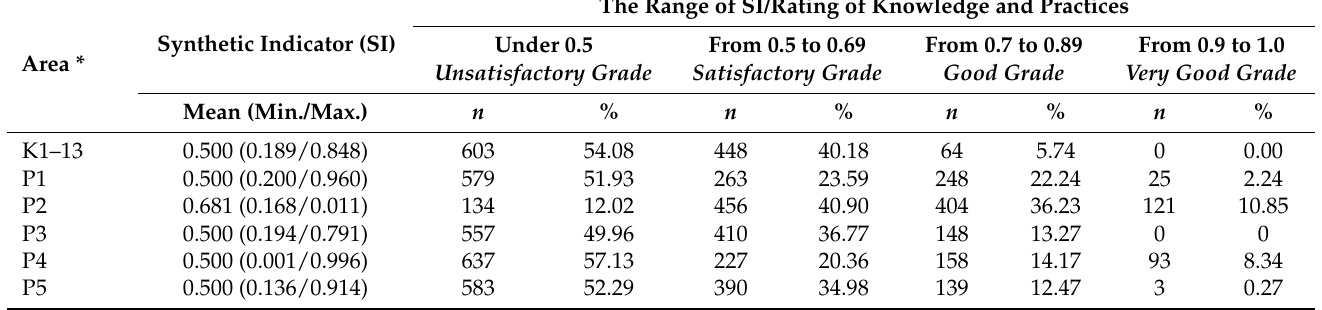
Table 3. Average values of the calculated synthetic indicators (SI) for knowledge (K1–13) and the selected areas of practices (P1–P5) of the respondents ( n = 1115) with assigned